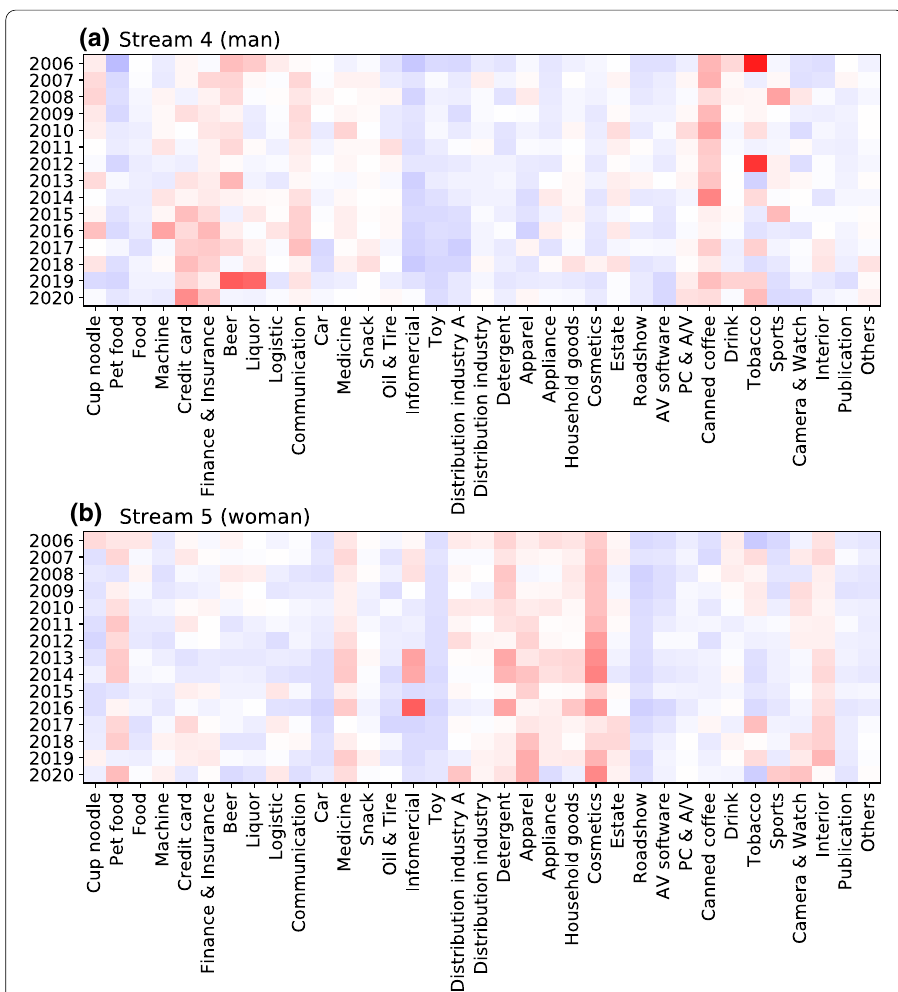
Fig. 5 Relationship w l , k between the categories and the communities included in a Stream 4 and b Stream 5, for each